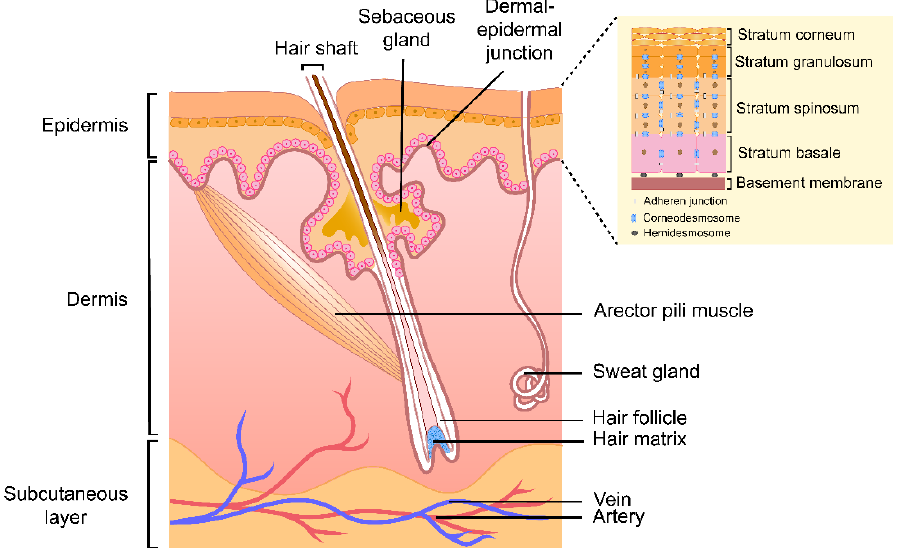
Figure 1. Anatomy of normal human skin.